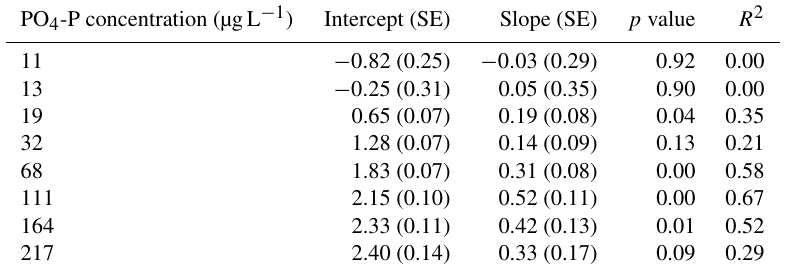
Table A1. Regression coefficients and model fits associated with Fig. 2a in the main text. Slopes and intercepts are given along with the standard error (SE) of the estimates, the p value associated with the slope, and the coefficient of variation ( R 2 ) .